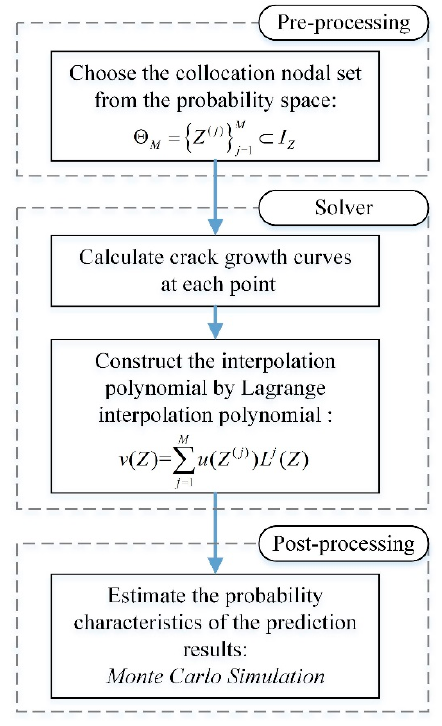
Figure 2. The framework of the proposed approach.